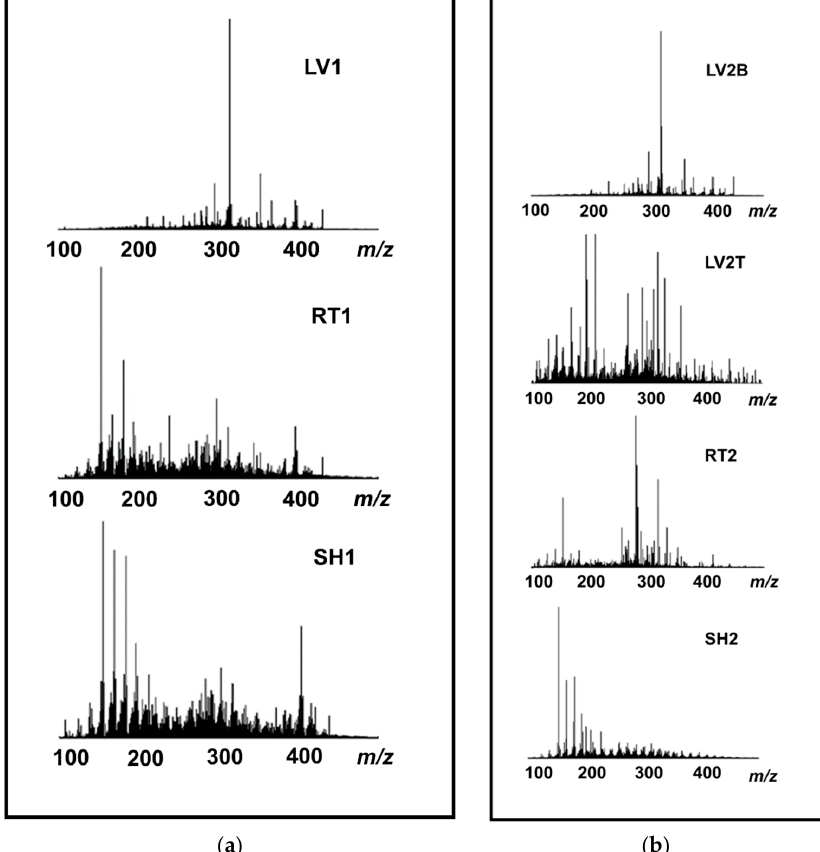
Figure 3. ( a ) APPI FT-ICR mass spectra of LV1, RT1, and HR1 of hemp distillates at pyrolysis stage 275–350 °C and condensed at 130 °C. ( b ) APPI FT-ICR mass spectra of LV2B, LV2T, RT2, and HR2